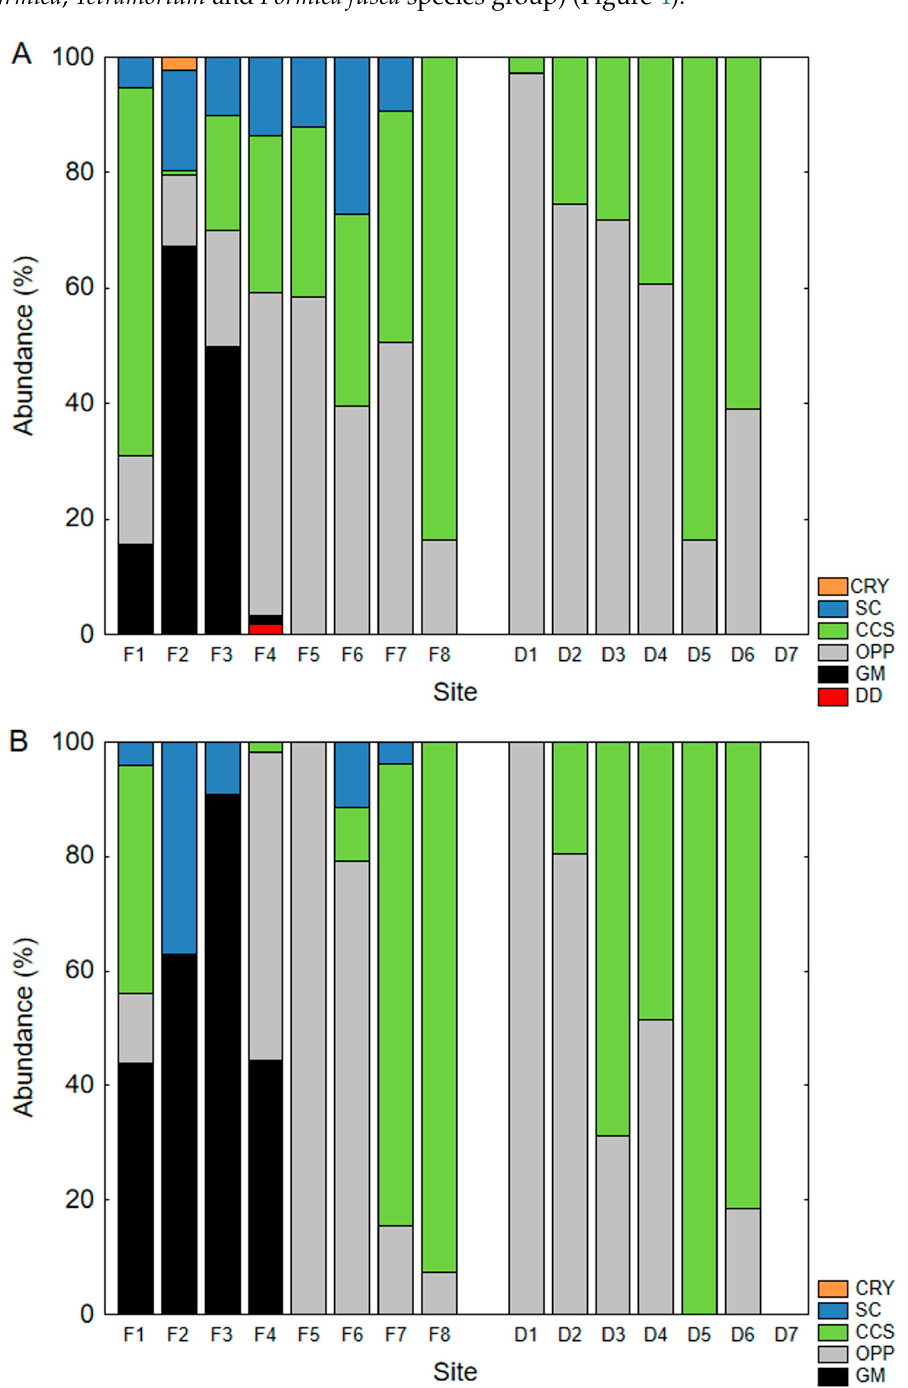
Figure 4. Functional group composition in pitfall traps ( A ) and at baits ( B ) at sites along the two bioclimatic gradients of increasing thermal stress in France (F1–F8) and Denmark (D1–D6). Bait data are for all times combined. The functional groups are: DD, Dominant Dolichoderinae; GM, Generalised Myrmicinae; OPP, Opportunists; CCS, Cold-climate Specialists; SC, Subordinate Cam- ponotini; and CRY, Cryptic Species. Site details are provided in Supplementary Materials S4 and